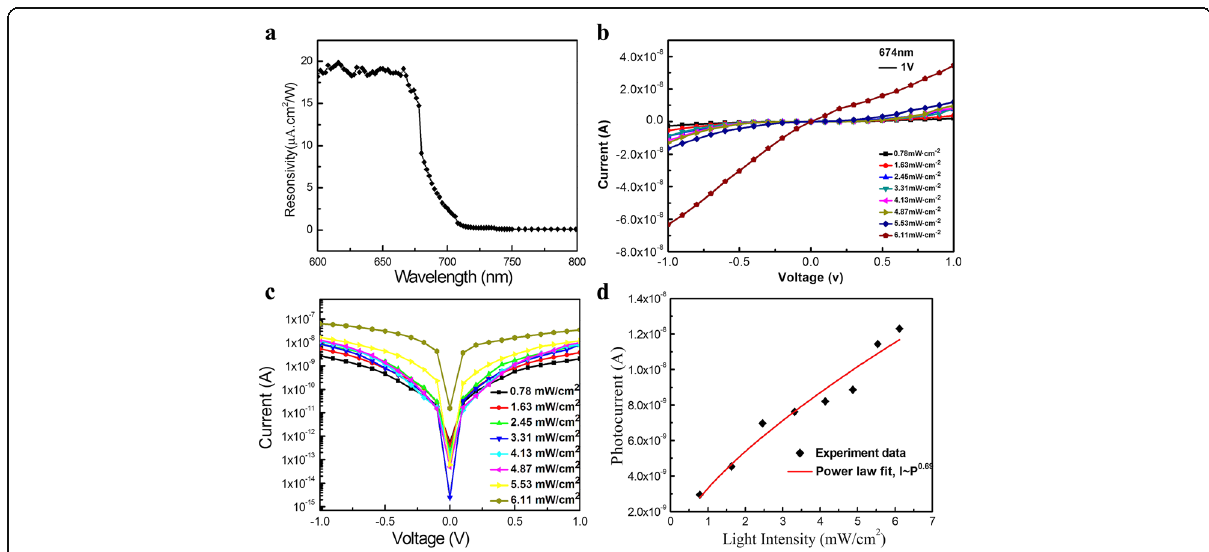
Fig. 8 The detector ’ s photoresponse properties of the CdSSe NB detector. a Spectral photoresponse measured at a bias of 1 V. b I – V curve at the excitation wavelength of 674 nm, a bias voltage of 1 V, and different power densities. c The logarithmic plot of b . d The relationship between the photocurrent and the optical power